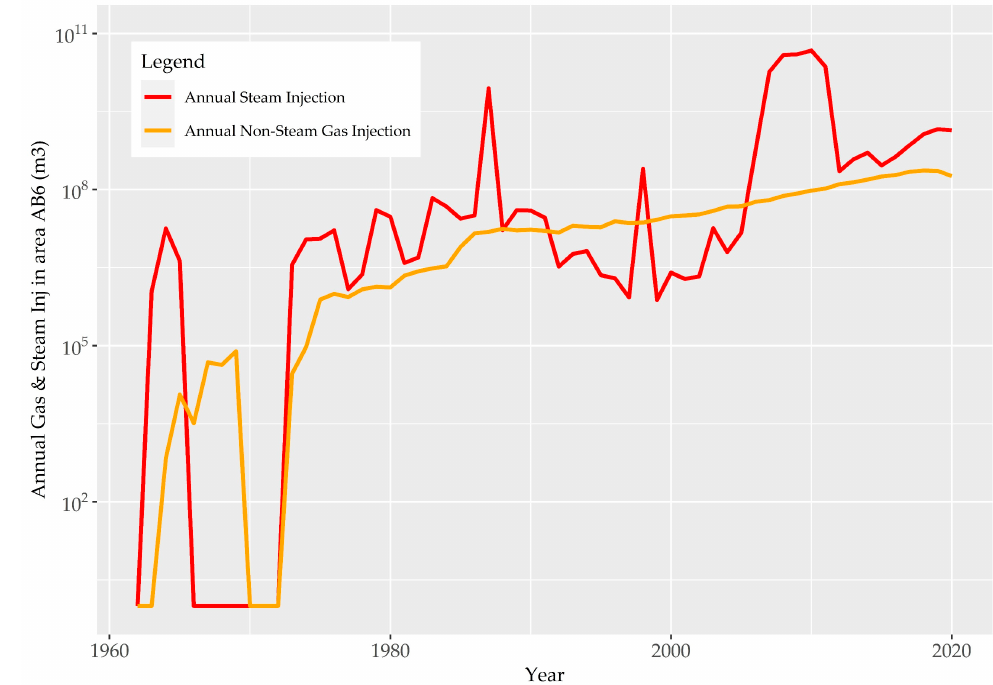
Figure 11. Calculated annual variations in steam and other gas phase injection volumes in area AB6. Source data extracted from geoLOGIC Systems databases © 2020.